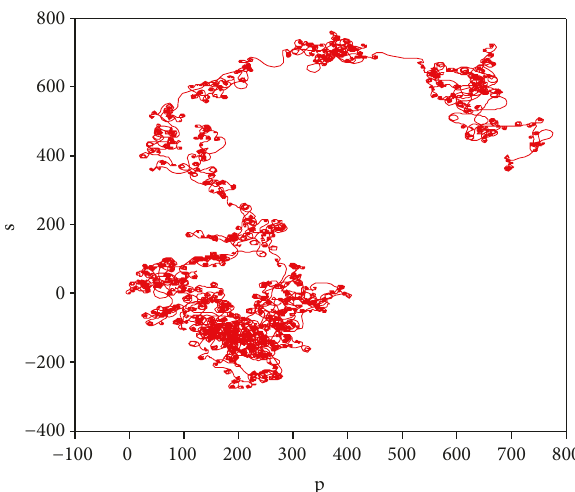
Figure 10: The dynamics of the translation components p − s of system (2) with a = 15 , b = 3 , and δ = 0 02 .